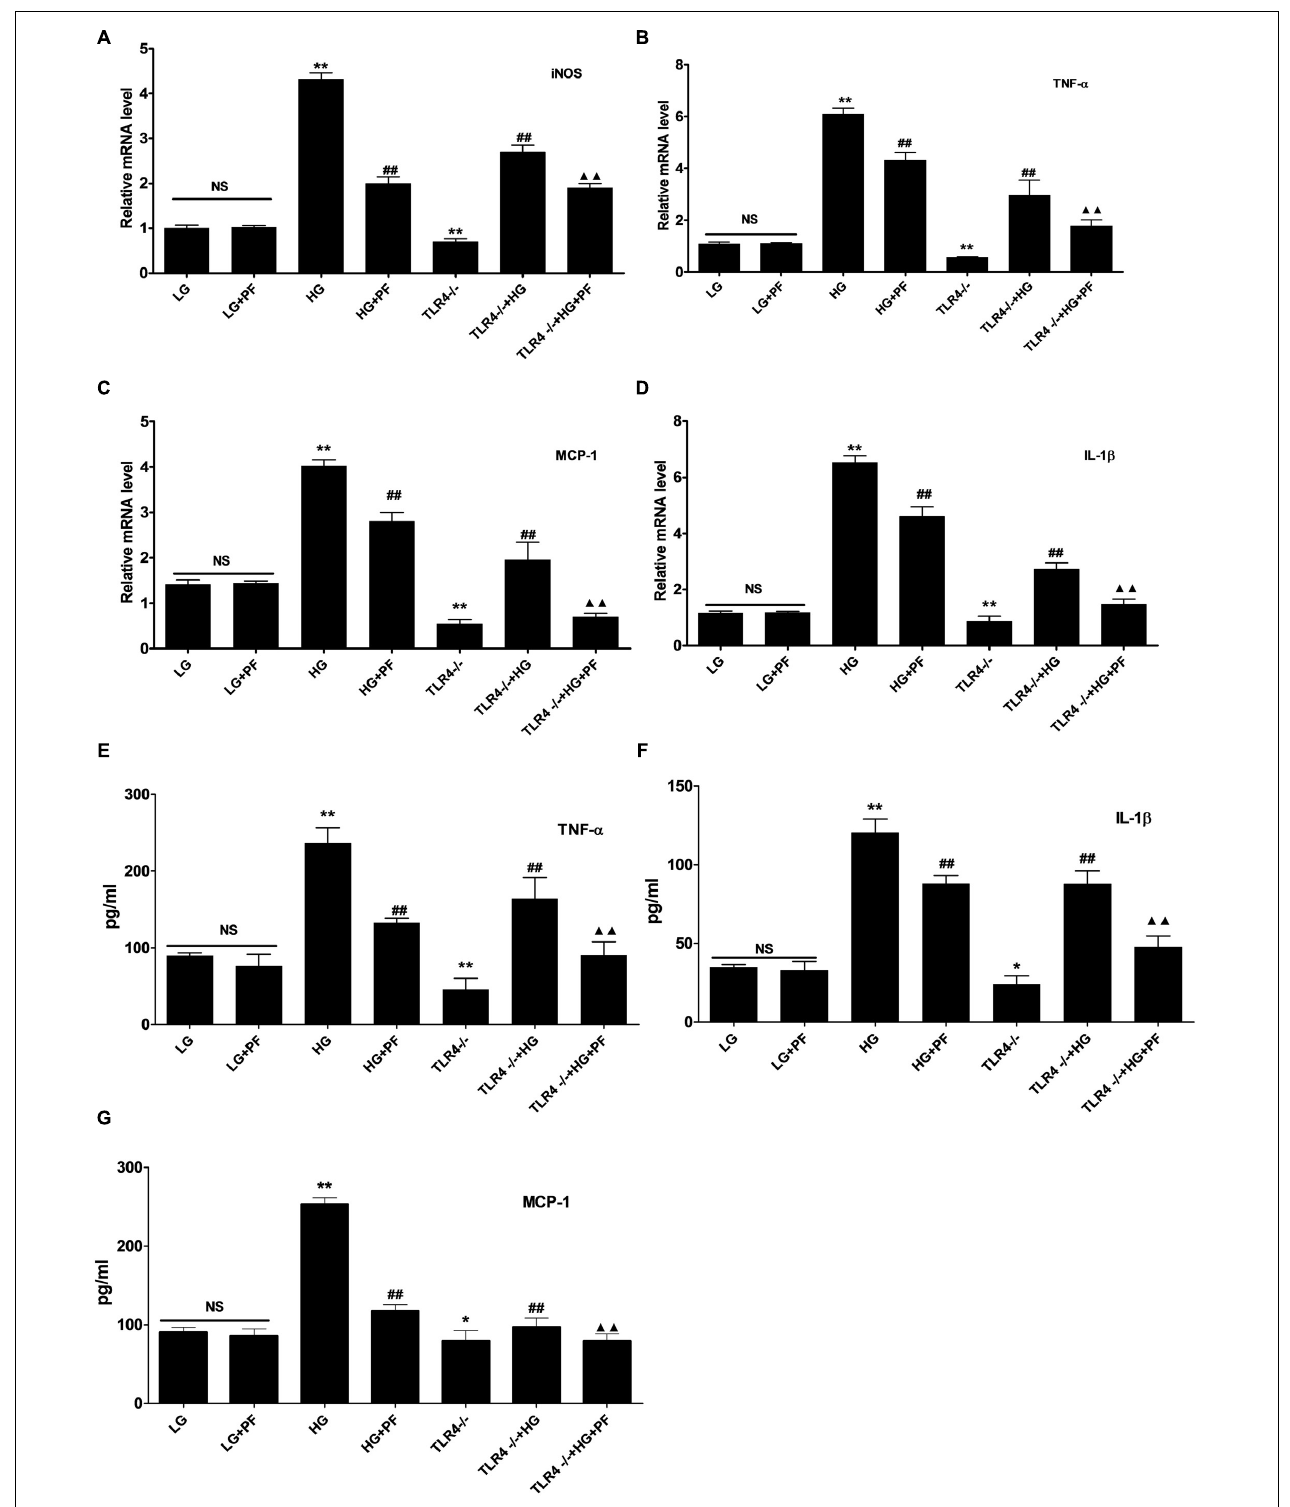
FIGURE 6 | PF could suppress iNOS and inflammatory factor levels in HG-induced macrophages. (A–D) Effects of PF treatment and TLR4 deficiency on HG-stimulated iNOS and inflammatory cytokine expression. BMDMs were treated with HG stimulation for 24 h, and mRNA levels were detected by qRT-PCR. (E–G) Detection of the levels of TNF- α , IL-1 β , and MCP-1 secreted by HG-stimulated BMDMs. Conditioned medium was removed, and ELISAs were used to detect soluble TNF- α , IL-1 β and MCP-1 peptides. ∗ P < 0.05 and ∗∗ P < 0.01 vs. the LG group; ## P < 0.01 vs. the HG group; (cid:78)(cid:78) P < 0.01 vs. the TLR4-/- + HG group; NS: not